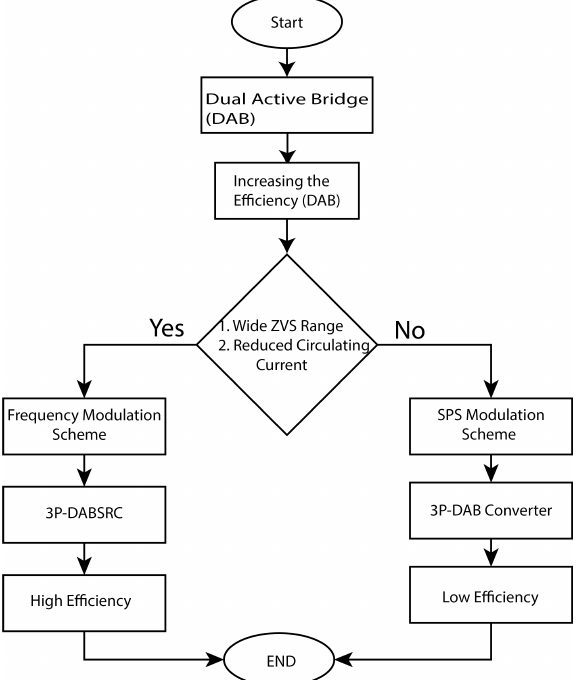
Figure 5. Preference for the frequency modulation technique over the SPS modulation